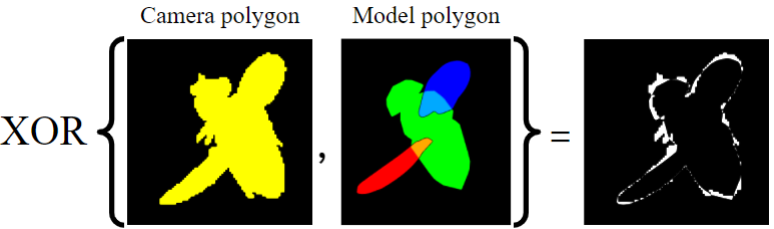
Figure 5. Single-frame loss function. XOR operation on the camera image mask (yellow) and the projected